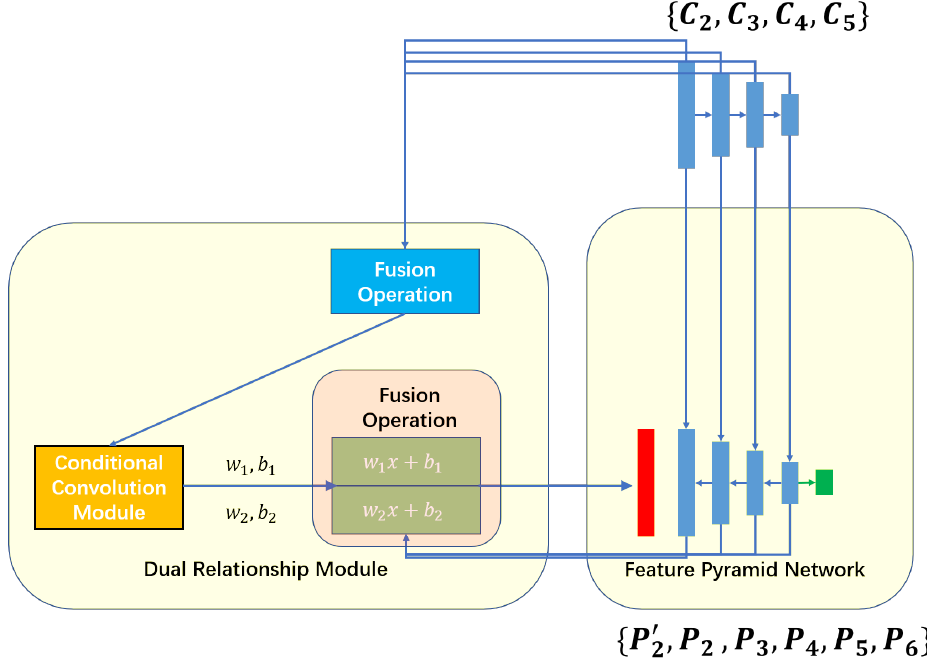
Figure 5. The construction process for the dual relationship